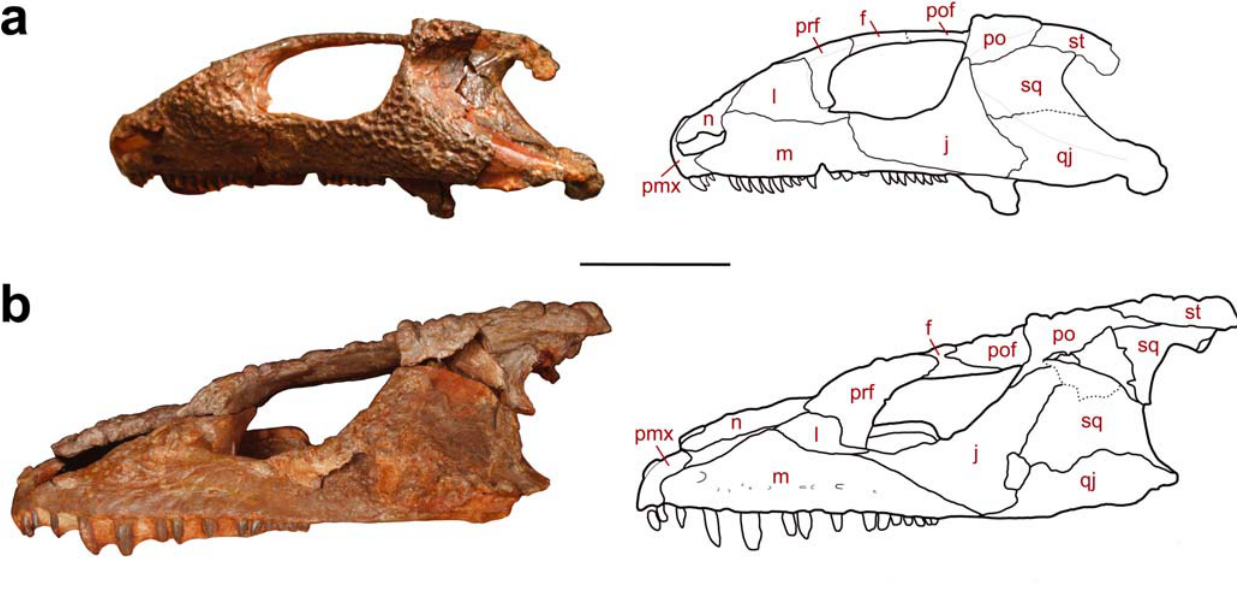
Figure 2. Hearing adaptations in the temporal region of the non-pareiasaurian parareptiles from the Mezen River Basin. (a) Lateral view of the skull of Bashkyroleter mesensis (PIN 162/30), which possesses the largest tympanum among the investigated taxa, as indicated by the non-sculptured posterolateral depression and the temporal emargination. (b) Lateral view of the skull of Macroleter poezicus (PIN uncataloged), the basalmost taxon within the clade. Bone abbreviations: f , frontal; j , jugal; m , maxilla; n , nasal; pmx , premaxilla; po , postorbital; pof , postfrontal; prf , prefrontal; qj , quadratojugal; sq , squamosal; st , supratemporal. Scale bar equals 2 cm.